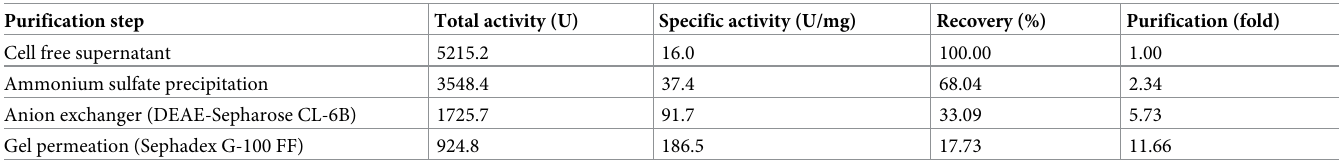
Table 2. Summary of elastase purification